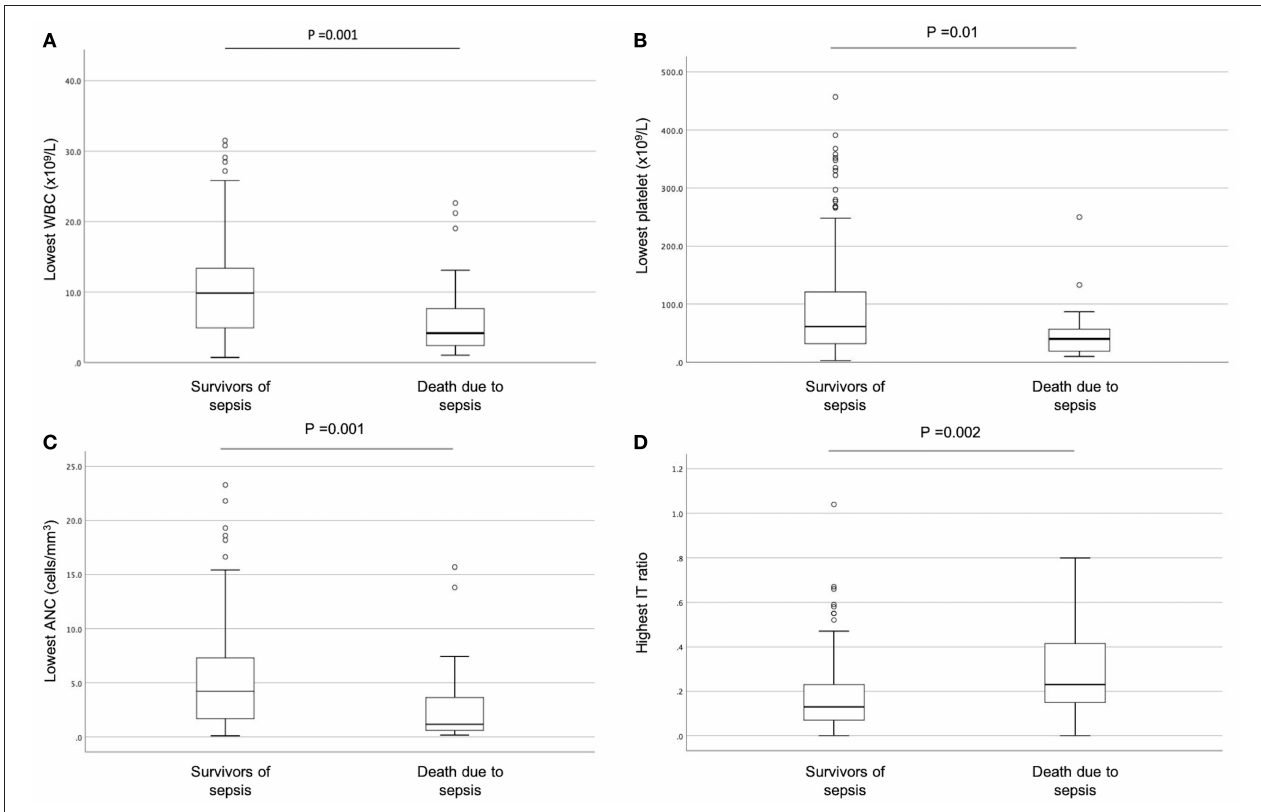
FIGURE 3 | Comparisons of laboratory parameters between VLBW infants who died and infants who survived late onset sepsis. Comparisons of the following parameters during LOS episode: (A) lowest WBC, (B) lowest platelets, (C) lowest absolute neutrophil count, (D) highest I: T ratio. The open circles in the graphs indicate